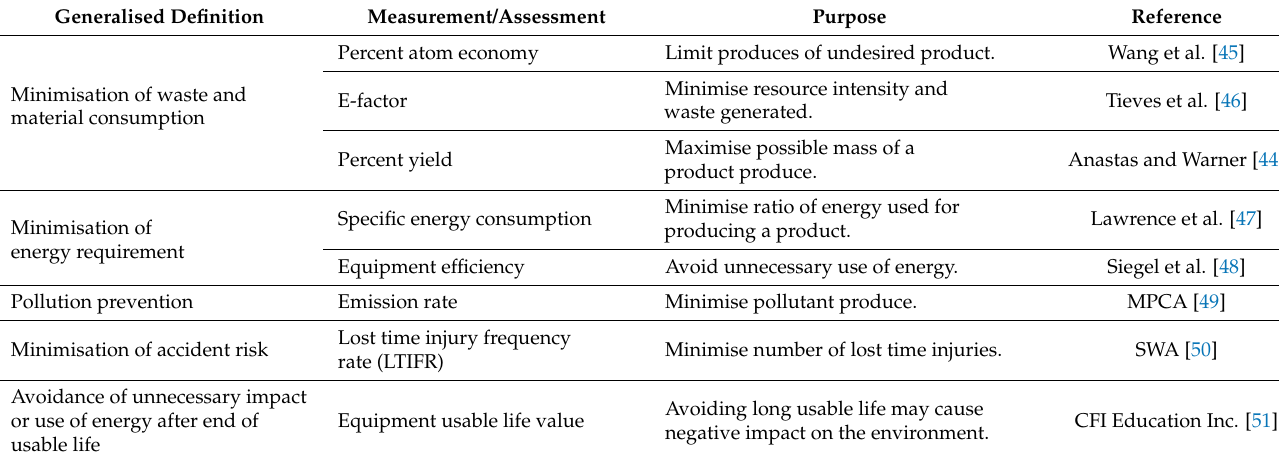
Table 2. Green definitions of process with the measurement/assessment